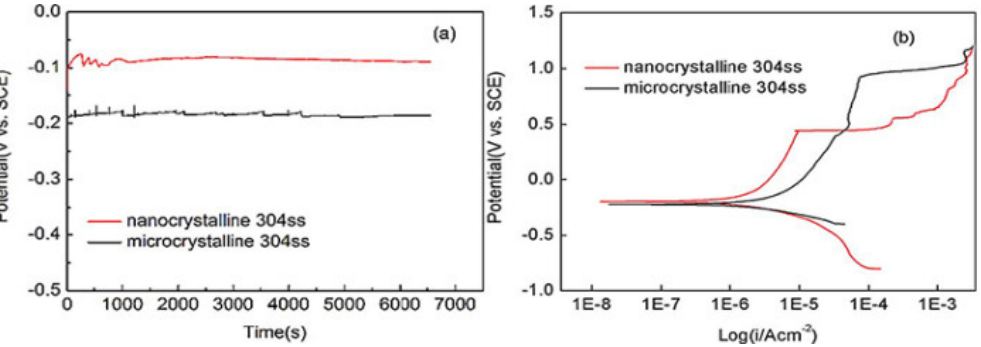
Figure 3. The electrochemical curves of ( a ) OCP and ( b ) polarization of microcrystalline 304 SS and nanocrystalline 304 SS in artificial saliva. Reprinted with permission from Ref. [49]. Copyright 2011, Elsevier.